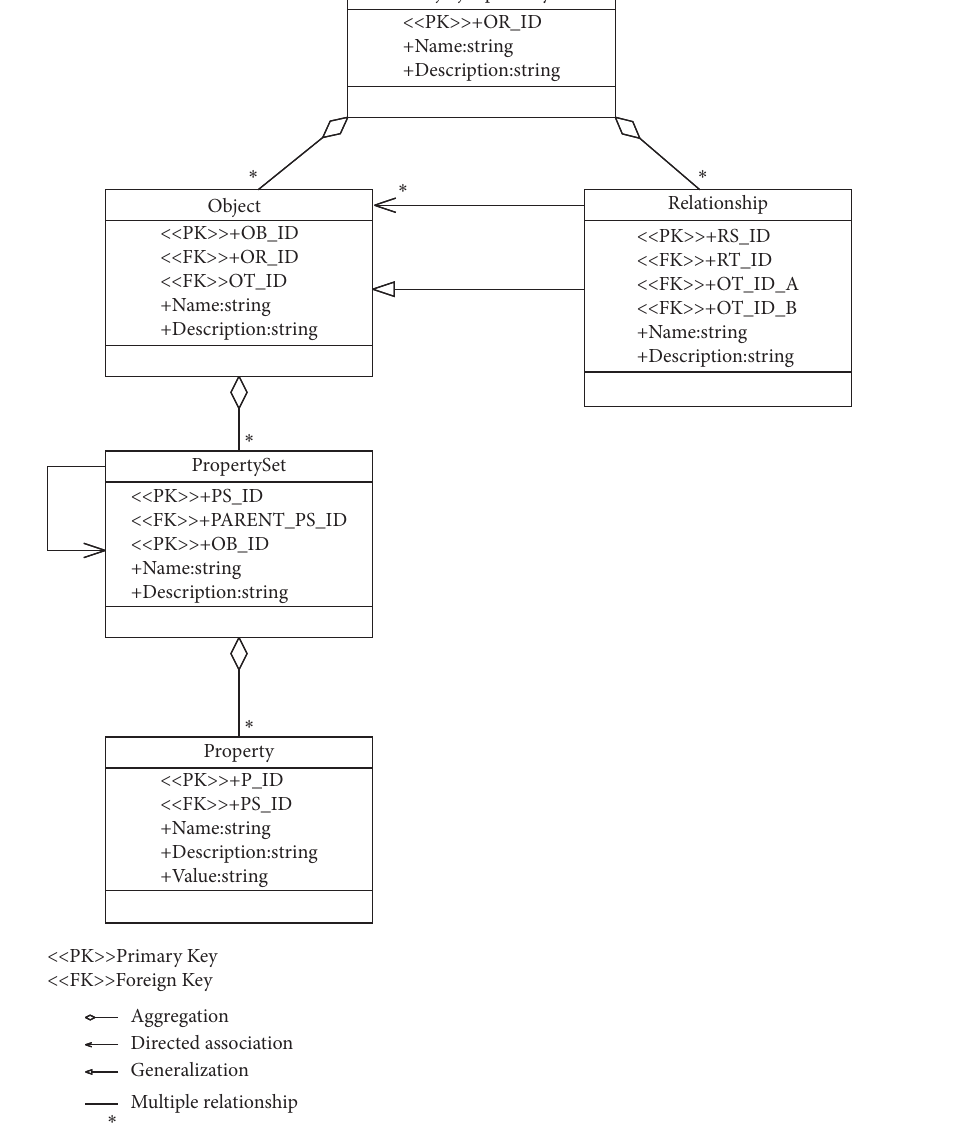
Figure 10: BIM-based data integrated database schema structure. (a) Domain part. (b) ObjectRepository